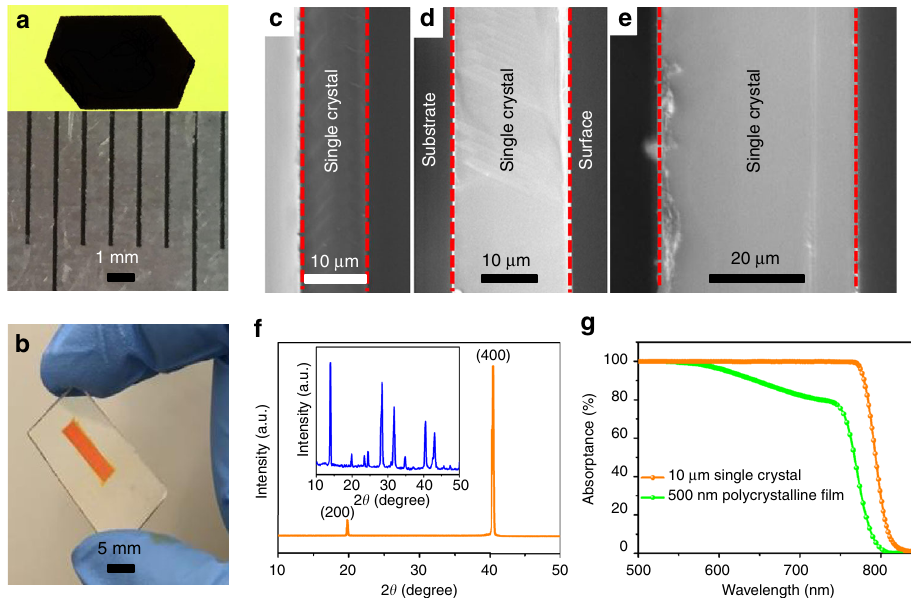
Fig. 3 Characterization of perovskite thin single crystals. Photographs of a methylammonium lead triiodide (MAPbI 3 ) thin single crystal and b methylammonium lead tribromide (MAPbBr 3 ) thin single crystal using the hydrophobic interface con fi ned lateral growth method. Cross-sectional SEM images of the MAPbI 3 thin single crystals with different thickness: c ≈ 10 μ m, d ≈ 20 μ m, e ≈ 40 μ m. f X-ray diffraction patterns of a MAPbI 3 thin single crystal and the grounded powder (inset). g Absorption spectra of a 10- μ m-thick MAPbI 3 thin single crystal and a 500-nm-thick polycrystalline fi